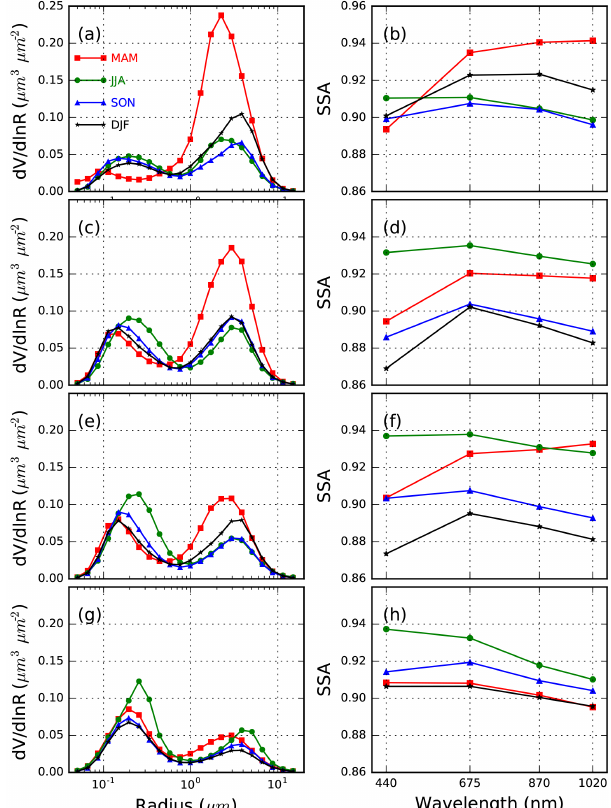
Figure 7. Seasonal aerosol size distribution (a, c, e, g) and spectral SSA (b, d, f, h) in the LP, NCP, YRD and PRD regions,